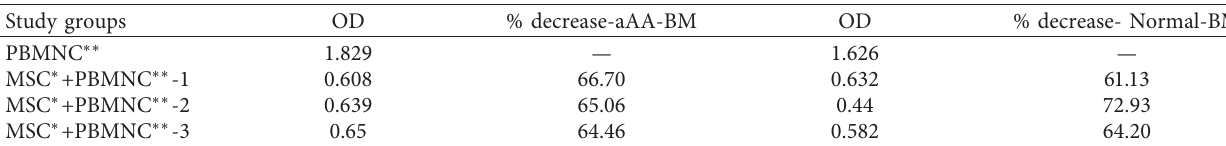
Table 2: Tabular representation of the comparative one-way mixed lymphocyte reaction data for the three MSC donors from normal and aAA patients, displaying the result as % decrease of immune cells P value <